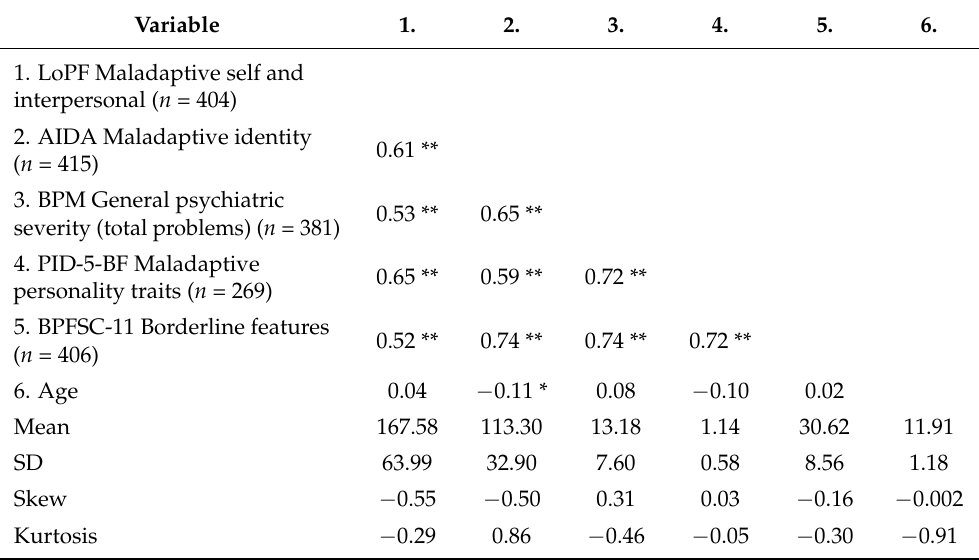
Table 2. Bivariate relations among study